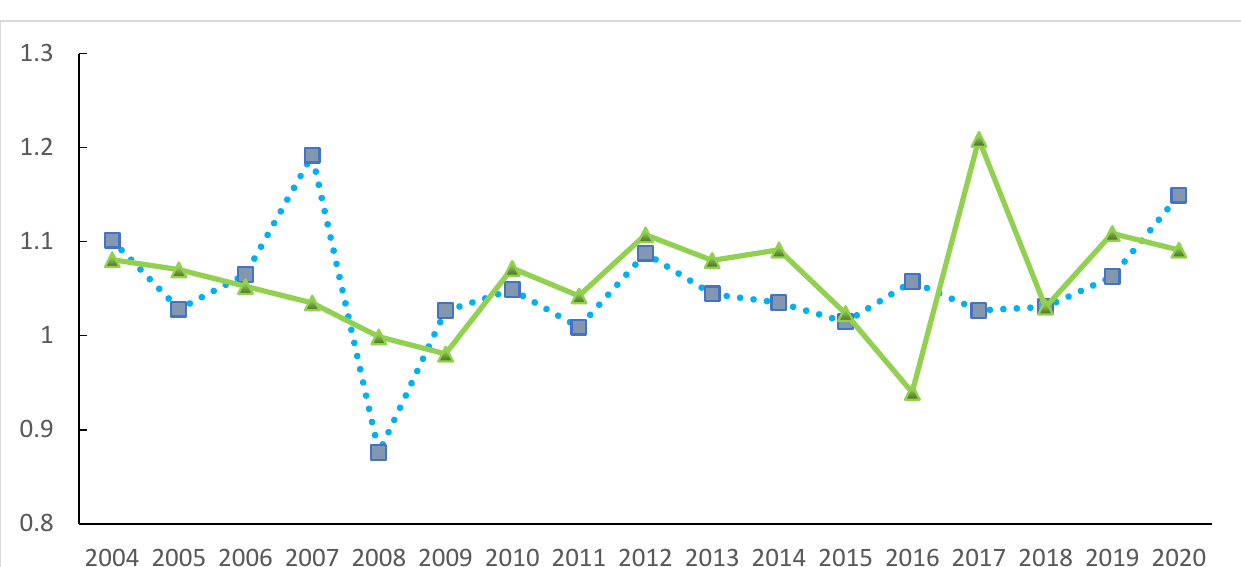
Figure 3. Comparison of GTFP between mariculture and freshwater aquaculture.